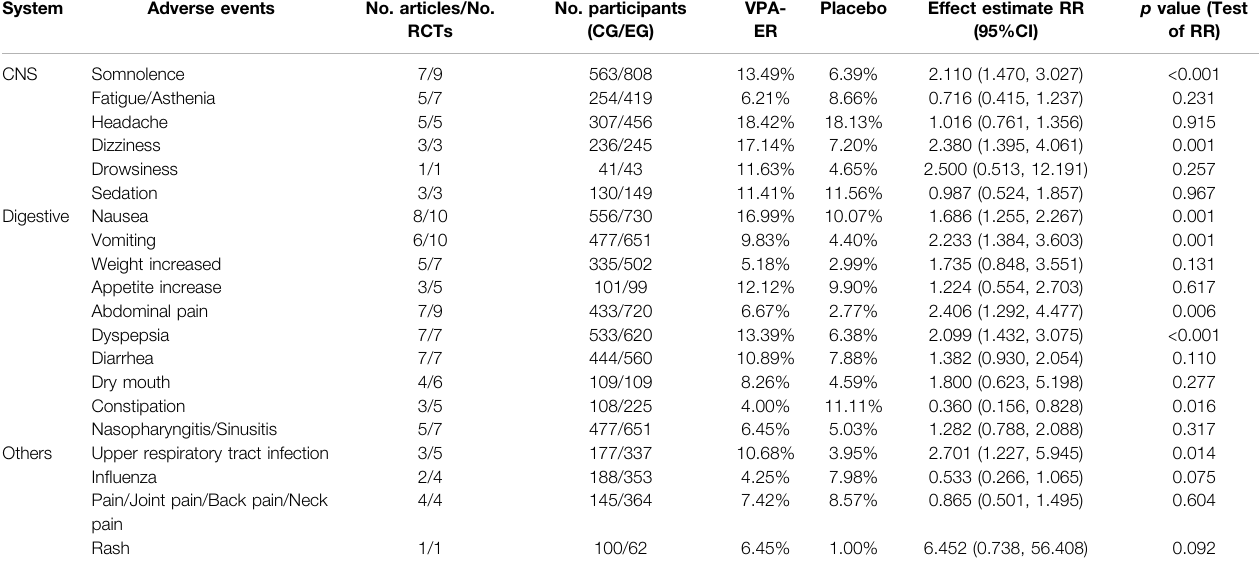
TABLE 3 | Adverse events (VPA-ER vs. placebo). System